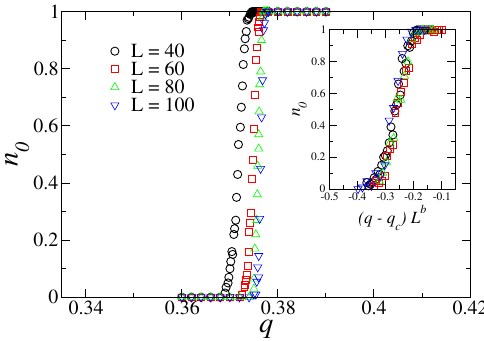
Fig. 3. Fraction n 0 of samples (over 200 simulations) that reach the absorbing state with all neutral opinions as a function of q for the model de¯ned on 2D square lattices. Results are for g ¼ 1 and typical lattice sizes L (main plot). In the inset, it is exhibited the corresponding scaling plot. The best collapse of data was obtained for